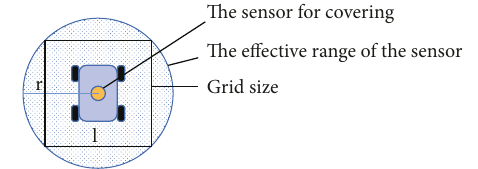
Figure 2: The relationship between grid size and the sensor